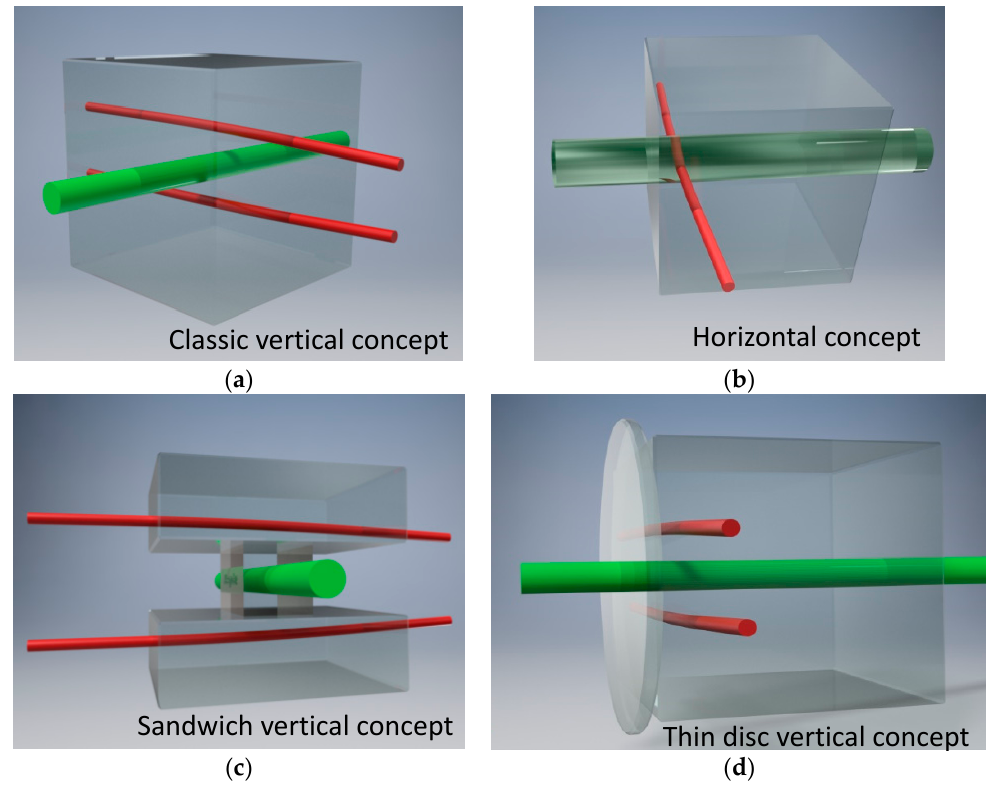
Figure 5. Different measurement concepts based on the LID technique: ( a ) Classic vertical concept, ( b ) horizontal concept, ( c ) Sandwich vertical concept and ( d ) Thin disc vertical concept. In all schemes, the green beam assigns the pump beam whereas the red beam(s) represent the probe beam(s).